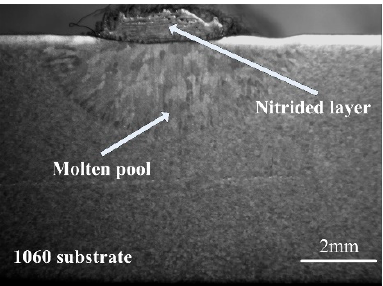
Figure 2. A typical cross-sectional picture of the nitrided layer.